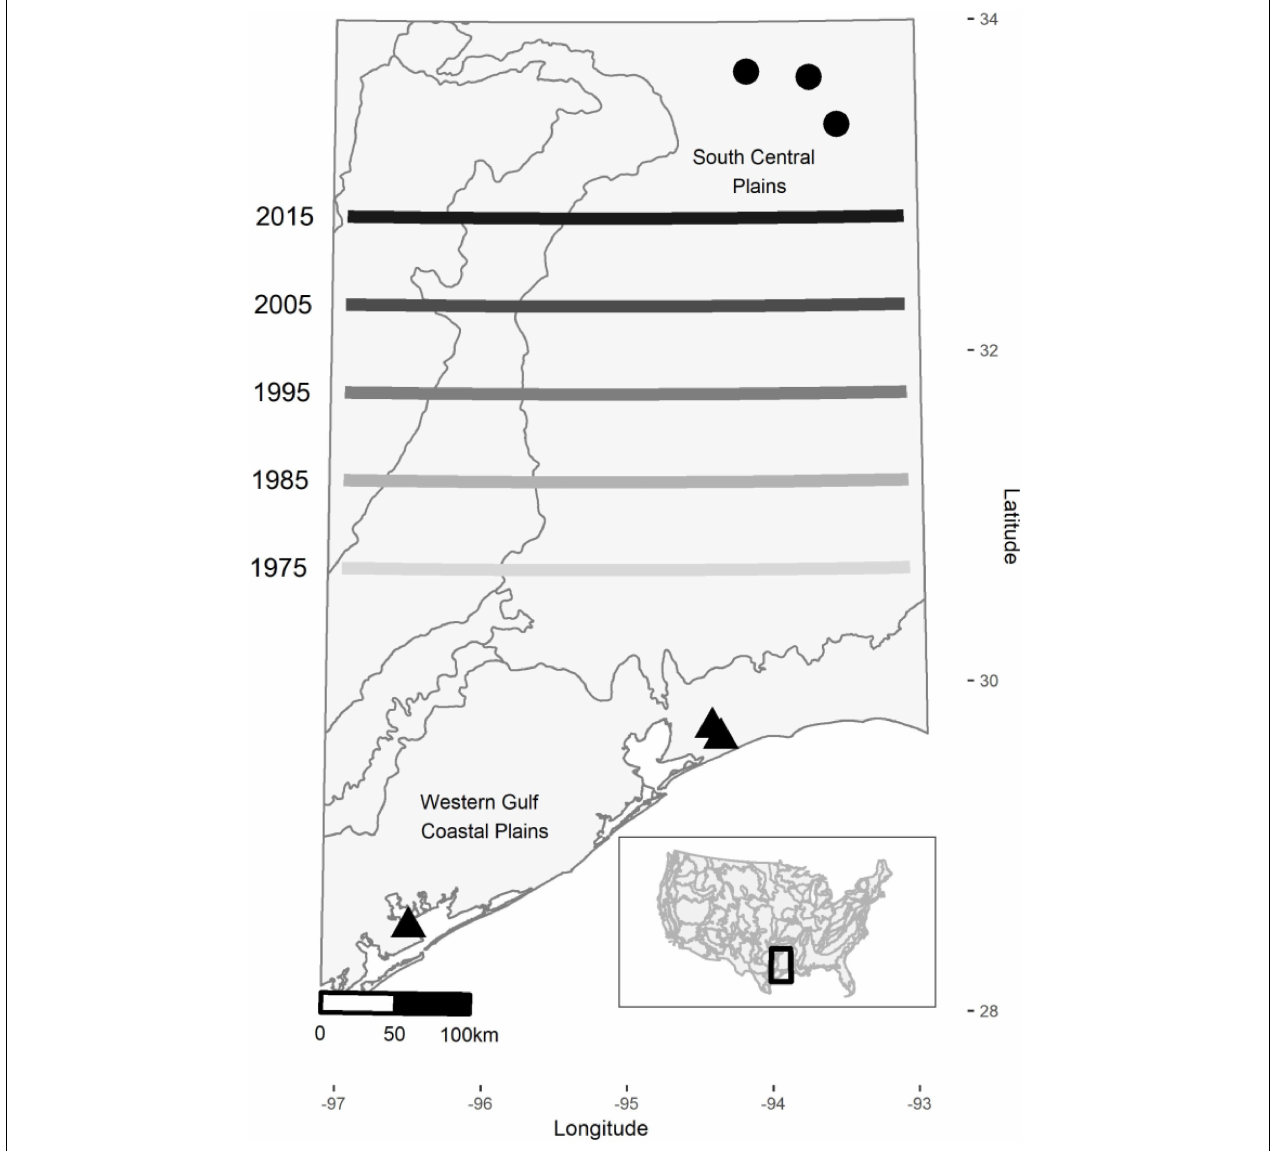
FIGURE 2 | Map showing location of breeding bird survey transects in the southern (triangles: Transect 1, Route ID 13, Latitude/Longitude coordinates 28.52/ − 96.50; Transect 2, ID 20, Lat./Long. 29.67/ − 94.34; and Transect 3, ID 21, Lat./Long. 29.74/ − 94.40) and northern (circles: Transect 1, ID 5, Lat./Long. 33.38/ − 93.47; Transect 2, ID 6, Lat./Long 33.66/ − 93.67; and Transect 3, ID 7, Lat./Long. 33.69/ − 94.12) spatial regimes. Contours show level 3 eco-region delineations based on United States EPA and lines denote northward movements of the southern regime front over time assessed by Roberts et al. (2019).